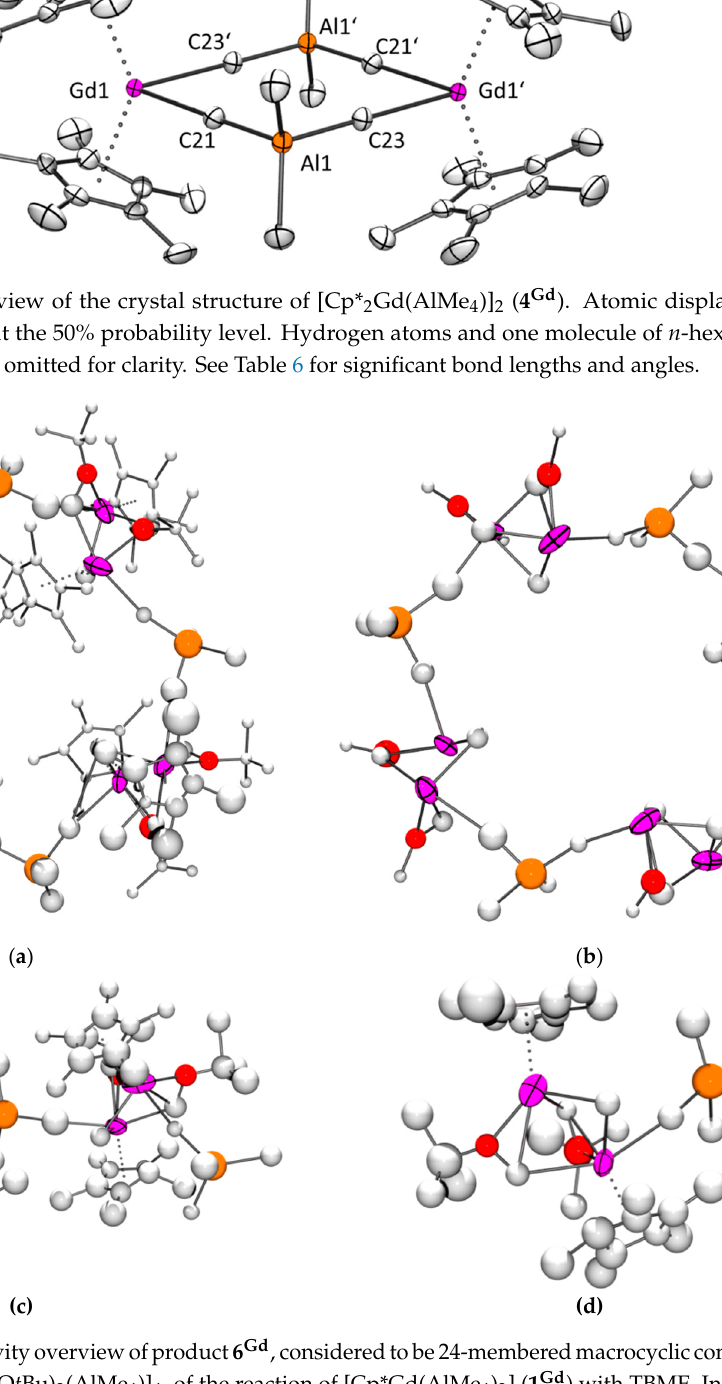
Figure 10. ORTEP view of the crystal structure of [Cp* 2 Gd(AlMe 4 )] 2 ( 4 Gd ). Atomic displacement parameters are set at the 50 % probability level. Hydrogen atoms and one molecule of n -hexane per asymmetric unit are omitted for clarity. See Table 6 for significant bond lengths and angles.